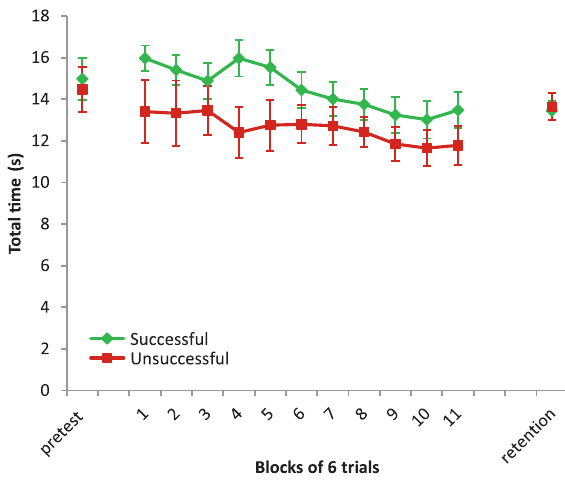
Figure 2. Duration of errors (mean ± SD ) in the task of line tracking for each of the experimental